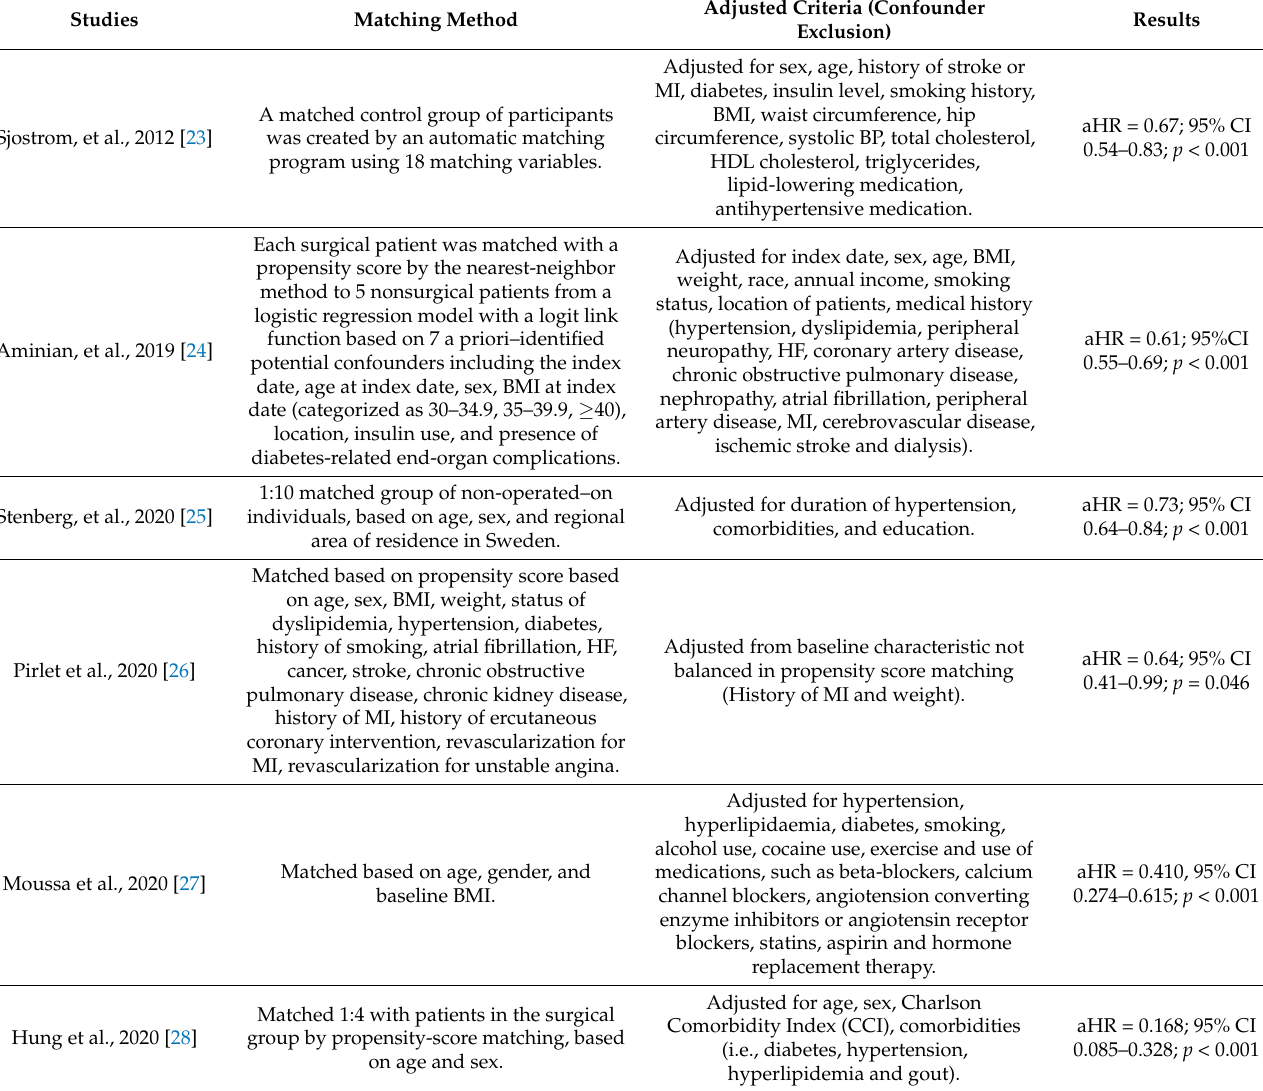
Table 3. Matching characteristics and adjusted results of the included